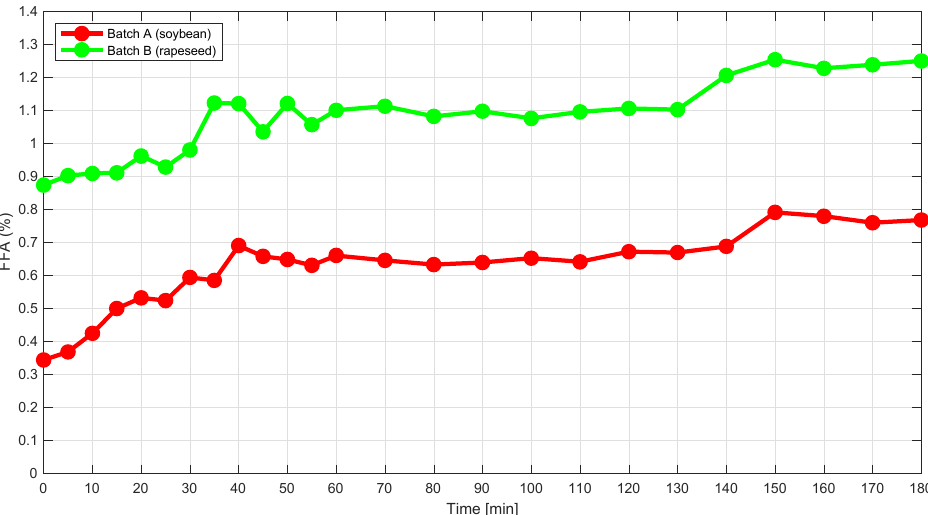
Figure 3. Graph showing the FFA content (titration) in percent (w/w) as a function of time for the two degumming reactions A) Soybean and B) Rapeseed. The estimated uncertainty of the FFA method is approximately 10 %.